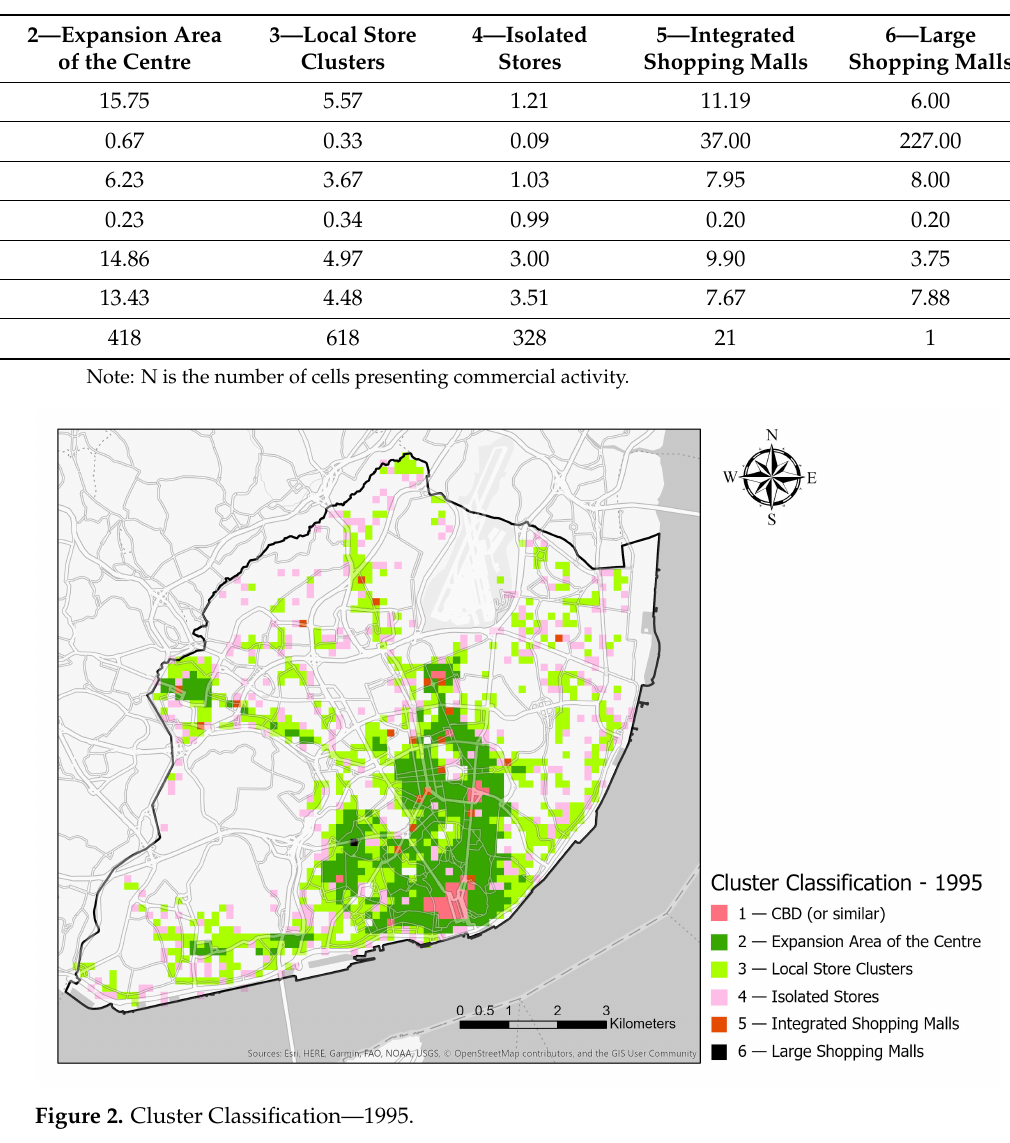
Table 2. Commercial Variables in 1995—Mean Value considering Cluster Membership.